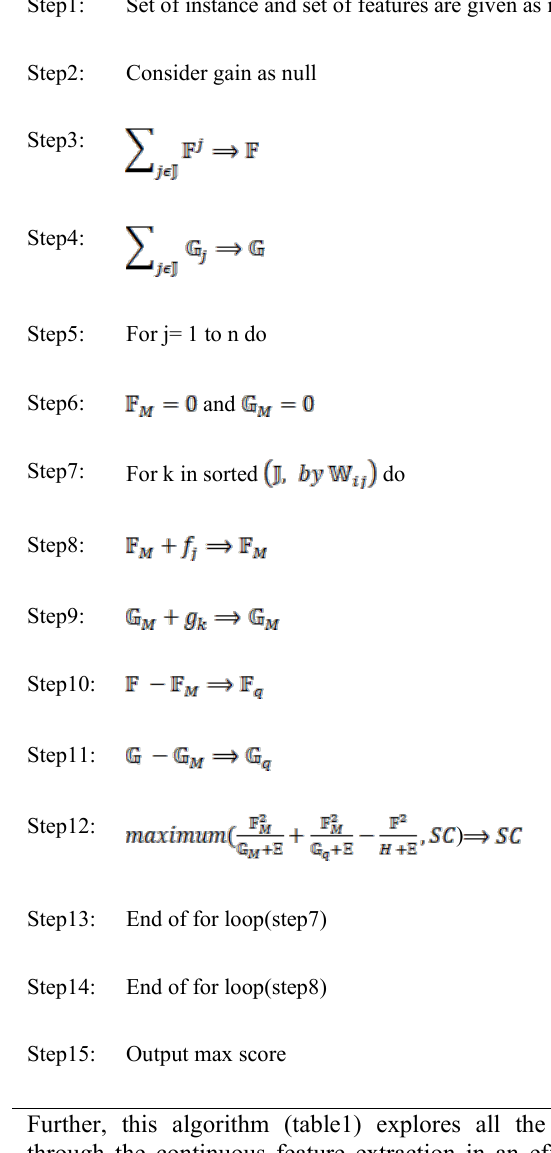
Table 1. Improvised_XGBoost